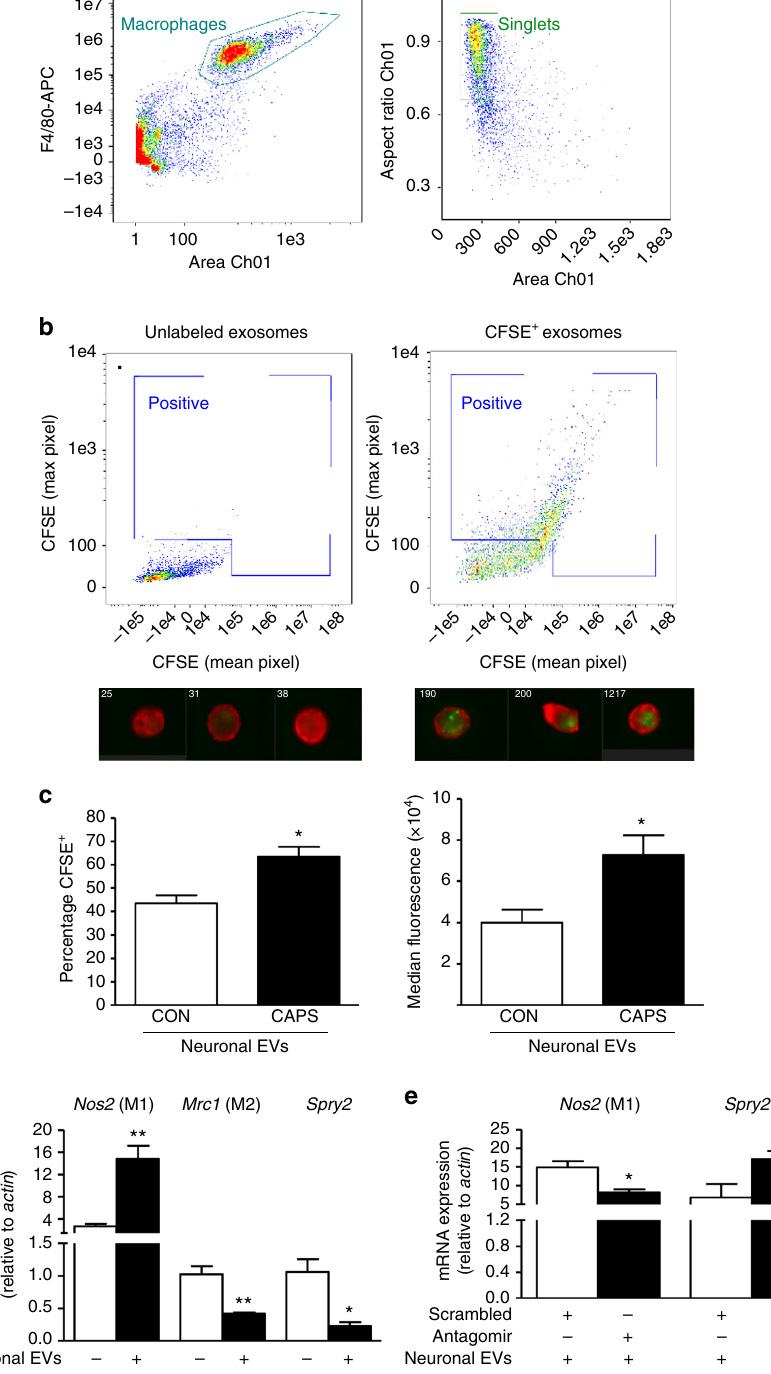
Fig. 4 Exosomes released from pure sensory neurons after capsaicin are phagocytosed by macrophages. a , b Representative scatterplots (gating strategy) and ImageStream TM images showing EVs (CFSE-labeled, green) uptake by macrophages (F4/80 + , red). EVs were isolated from culture media after incubation of pure DRG neurons with buffer control or CAPS for 3 h. c Percentage-positive and median fl uorescence intensity of CFSE + macrophages incubated with neuron-derived EVs. Data are means ± S.E.M., n = 4. * P < 0.05, compared to control, Student ’ s t- test. d Nos2, Mrc1 , and Spry2 mRNA expression levels in macrophages incubated with and without exosomes derived from CAPS-treated pure DRG neurons. e Nos2 and Spry2 mRNA expression levels in macrophages transfected with miR-21-5p antagomir or scrambled oligomer and incubated with EVs derived from CAPS-treated pure DRG neurons. Data are means ± S.E.M., n = 3; * P < 0.05 and ** P < 0.01 Student ’ s t-